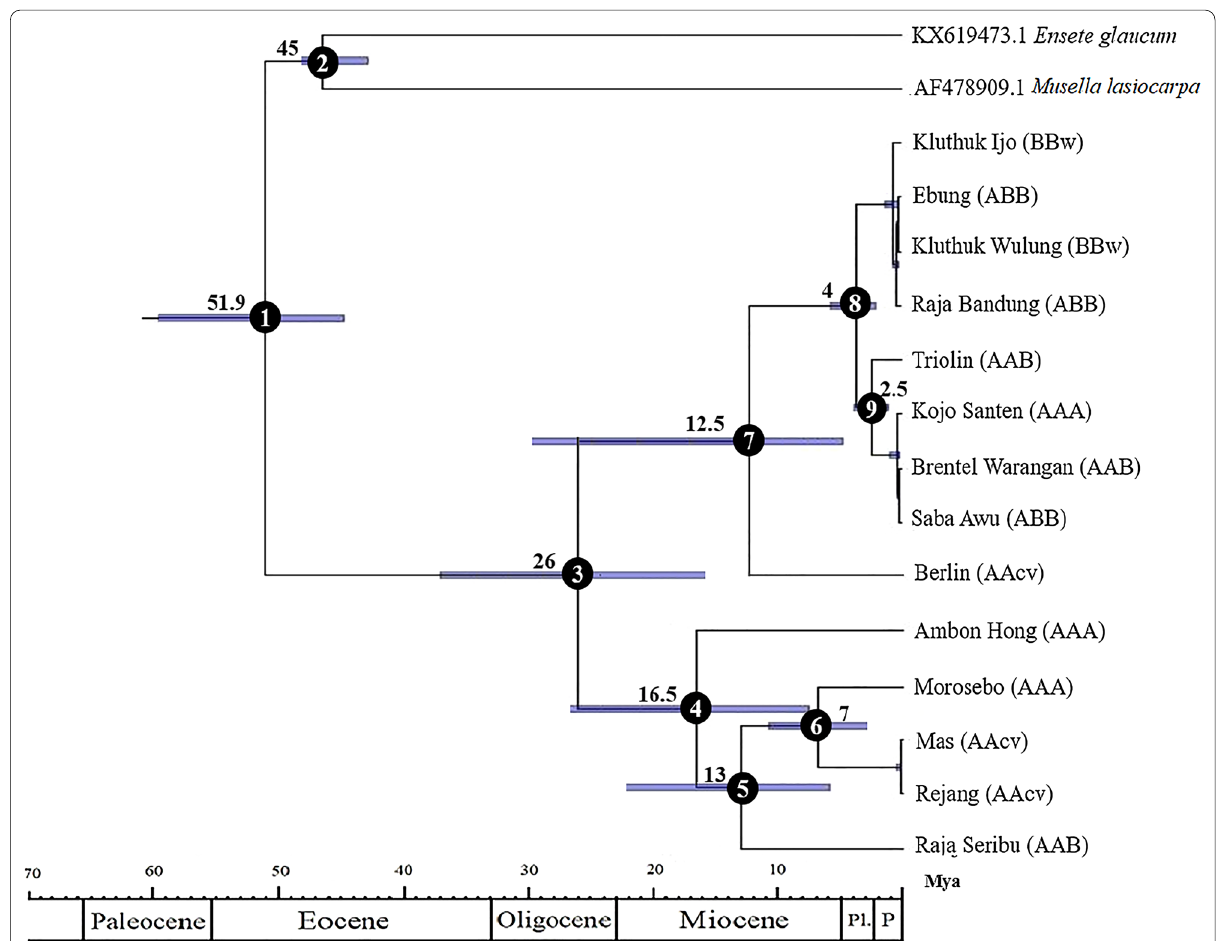
Fig. 5 Chronogram of the divergence time estimation of 14 banana cultivars based on mat K gene using BEAST. Median ages of nodes are shown, with horizontal bars indicating the 95% highest posterior density (HPD) intervals